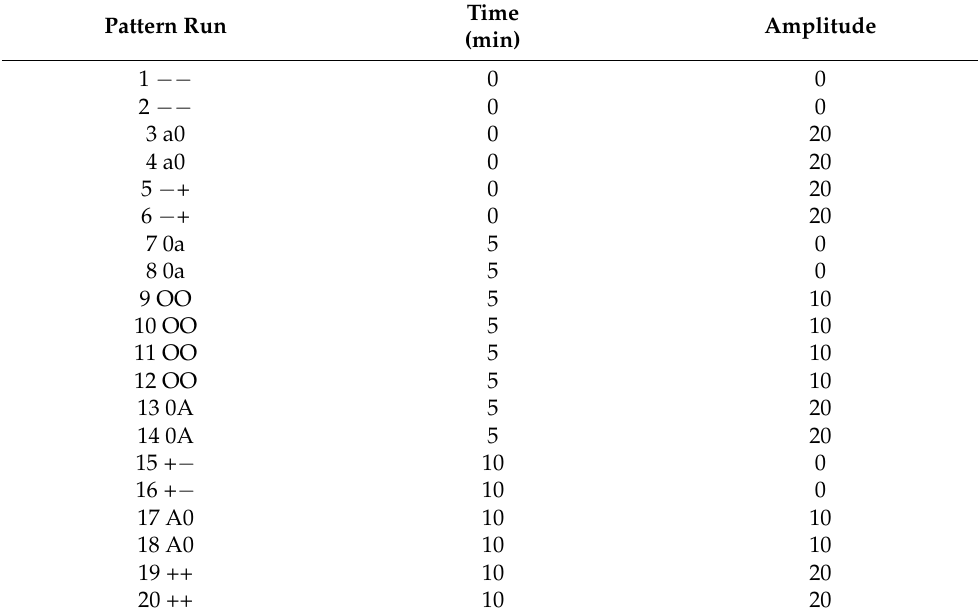
Table 1. Composite Central Design to optimize the best conditions for obtaining higher antioxidant capacity and total phenols in sorghum